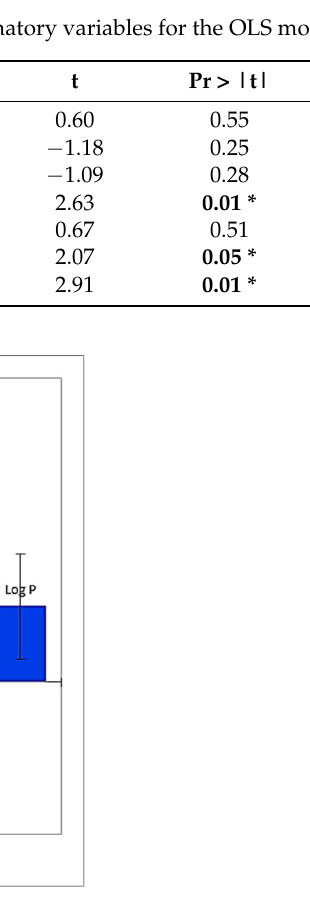
Figure 7. The standardised regression coefficients of the explanatory variables (95% confidence interval).